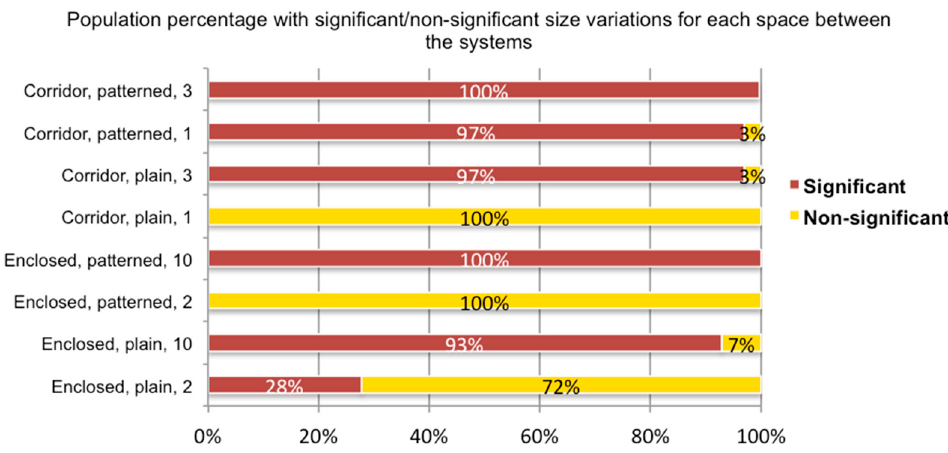
Figure 13. Population percentage with significant/non-significant space size variations between the systems. the